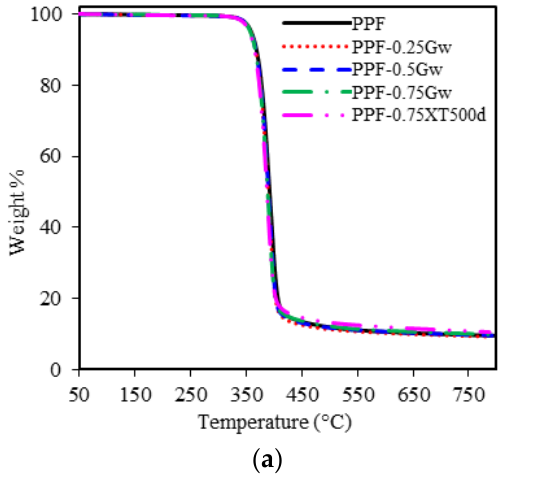
Figure 7. ( a ) Thermogravimetric curves of PPF samples; ( b ) zoomed region.